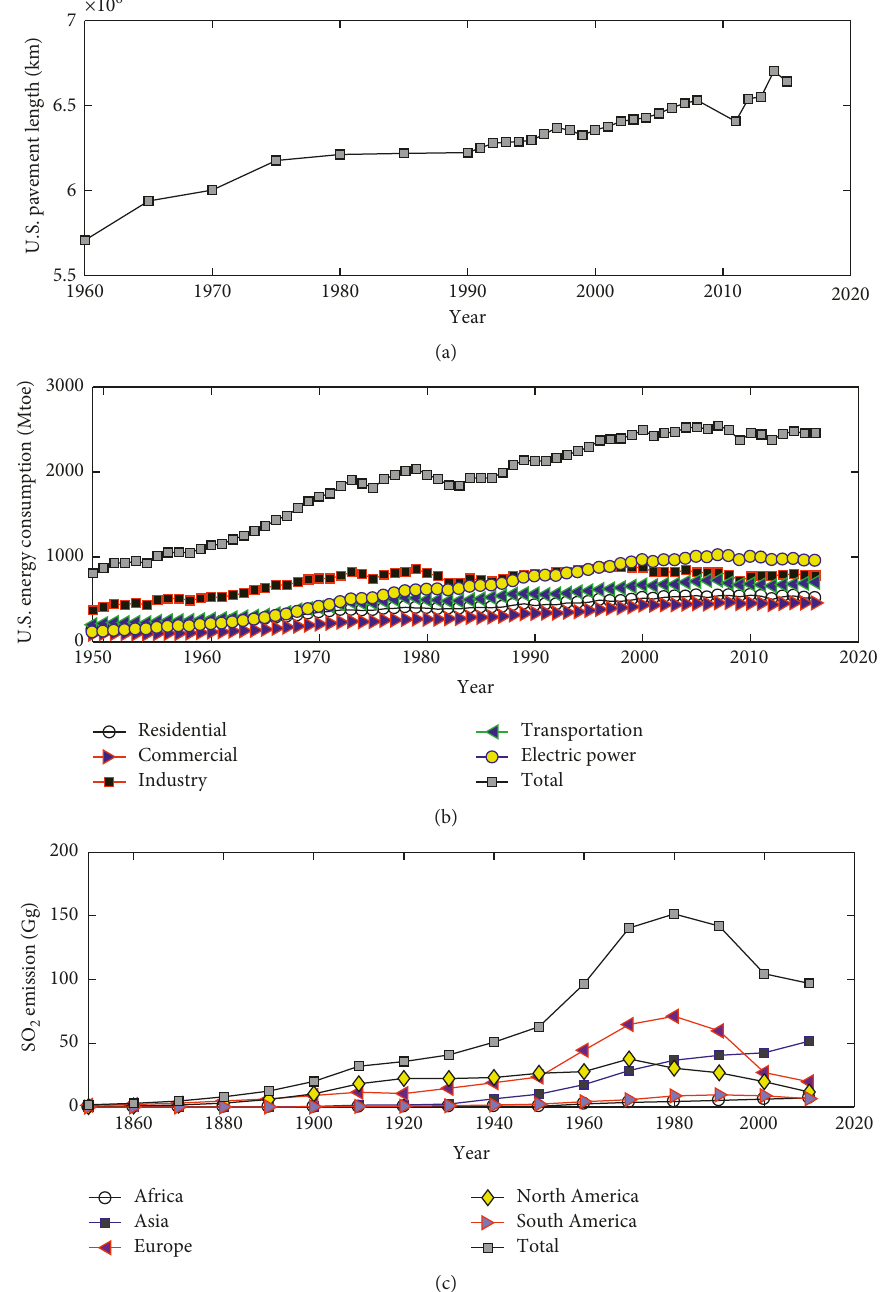
Figure 1: Increasing trends for pavement (a), annual energy consumption (b), and environmental pollution (c) (based on data from